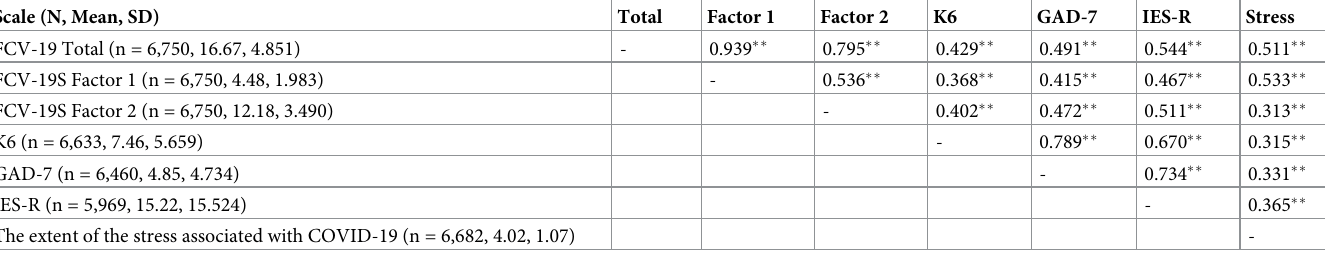
Table 4. Correlation between FCV-19S and each scale.